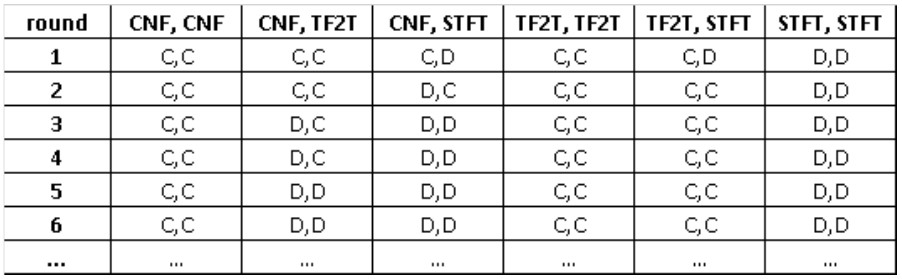
Patterns of interactions for every possible pair of strategies in an exemplary population consisting of CNF, TF2T and